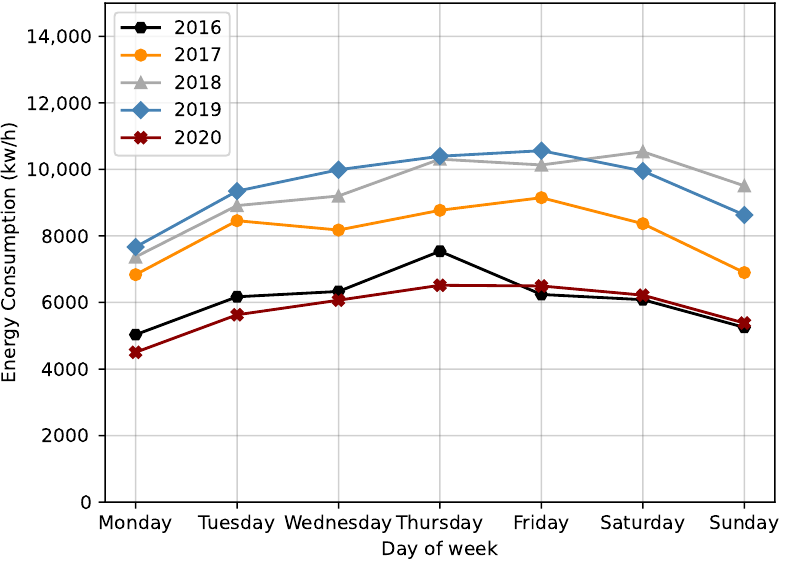
Figure 3. Day of the week variation of energy consumption over the